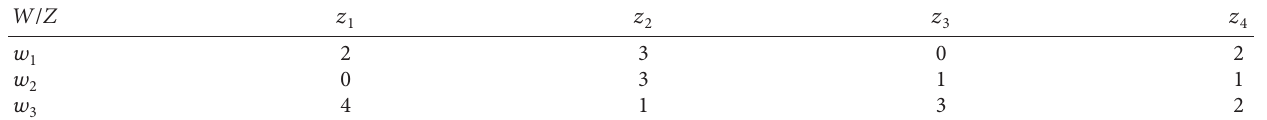
Table 2: Tabular representation of 5-soft set.